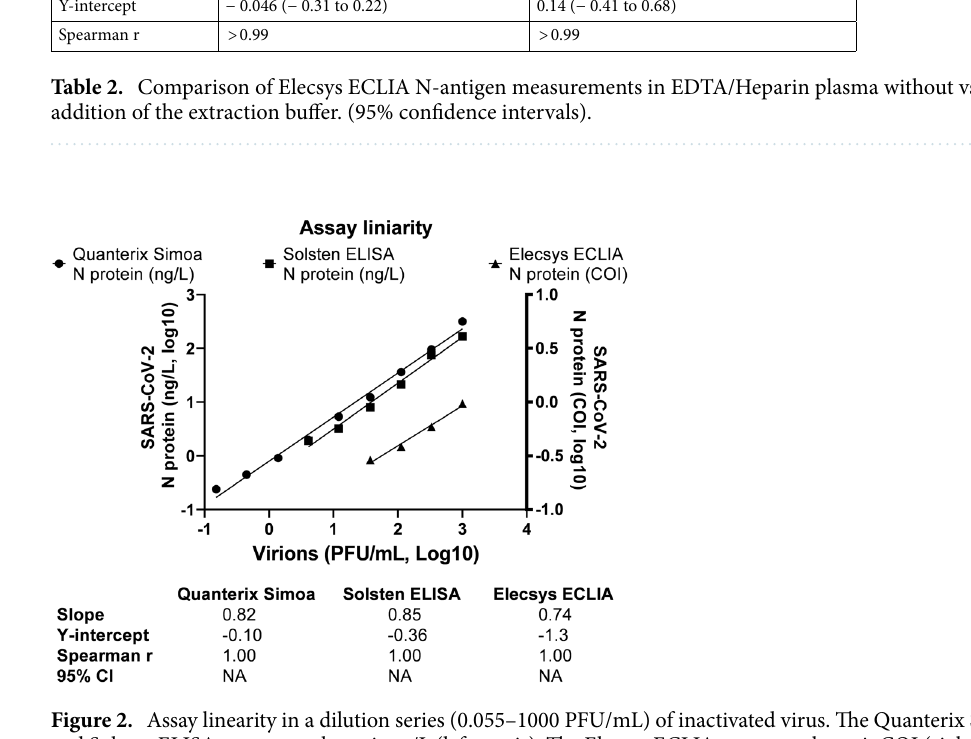
Figure 2. Assay linearity in a dilution series (0.055–1000 PFU/mL) of inactivated virus. The Quanterix Simoa and Solsten ELISA assays use the unit ng/L (left y-axis). The Elecsys ECLIA assay use the unit COI (right